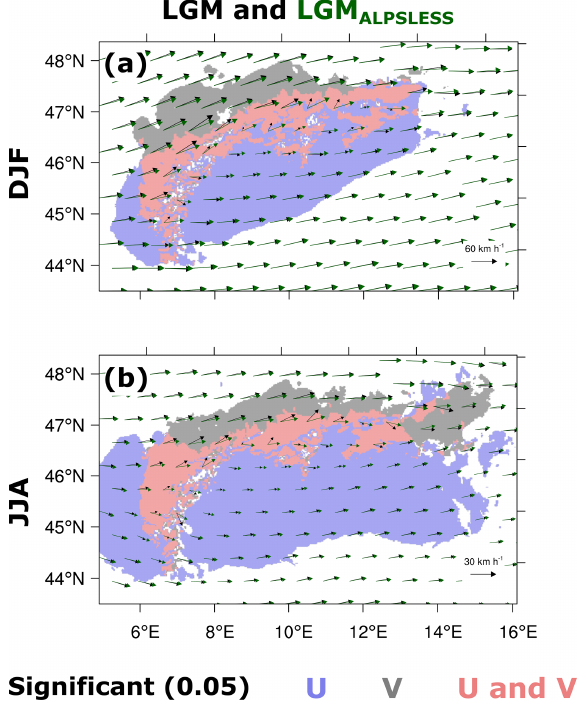
Figure 11. Climatological mean wind vectors over the Alps. Panel (a) represents wind vectors for DJF, black and green vectors correspond to LGM LGM and LGM ALPSLESS , (b) as panel (a) but for JJA. Red shading indicates statistically significant differences in zonal ( U ) and meridional ( V ) wind components at a significance level of 0.05 (two-tailed bootstrapping technique), blue and grey shading as the red one but only in U and V wind components, re- spectively. Please note that the reference wind vectors differ for DJF and